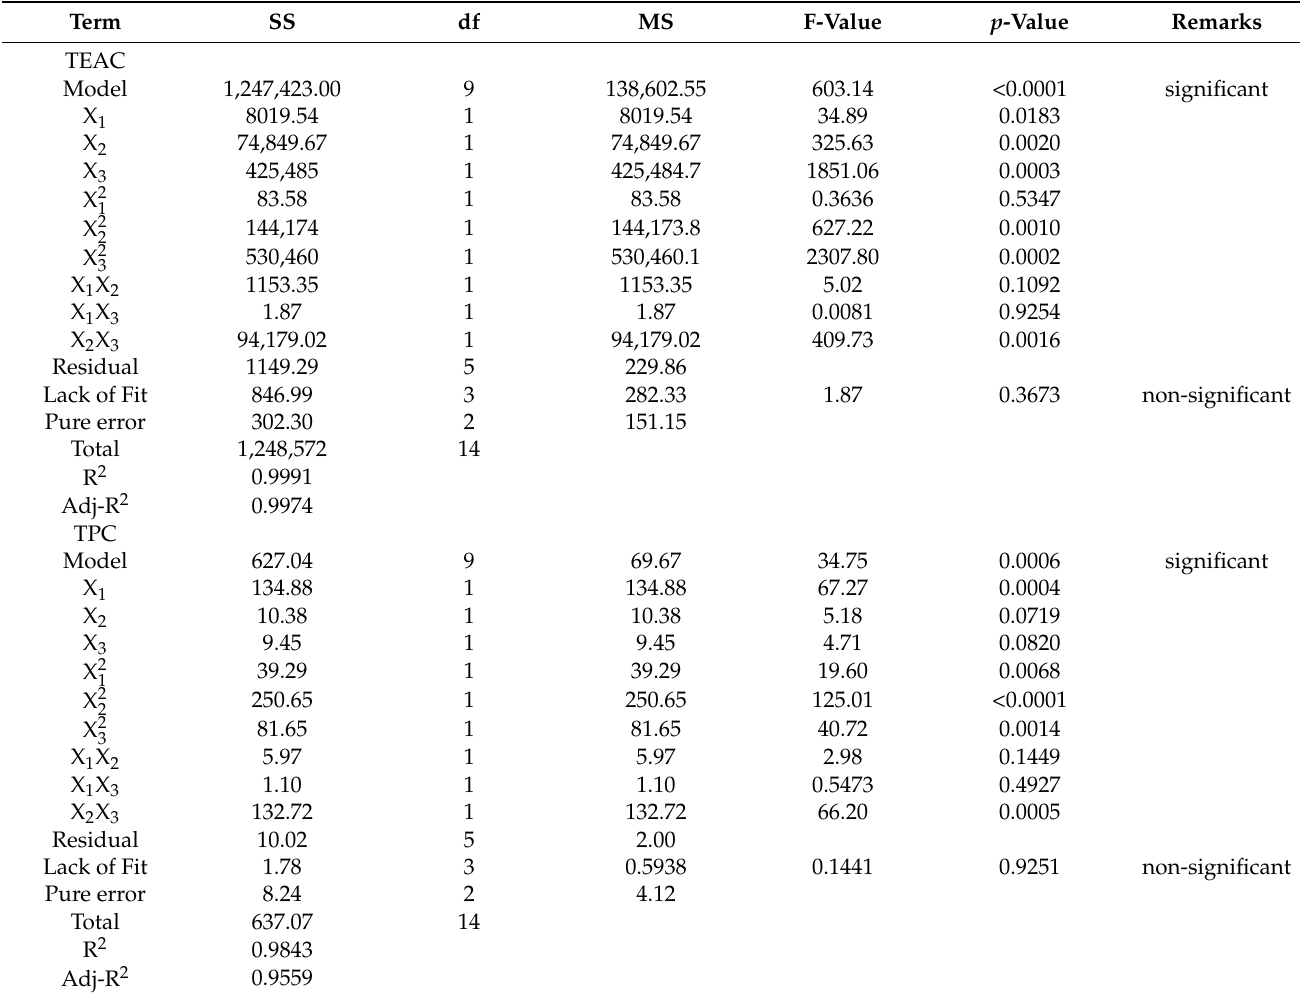
Table 2. The effects of different parameters on Trolox equivalent antioxidant capacity (TEAC) and total phenolic content (TPC) outcomes during optimization of Brazilian red propolis ethanolic